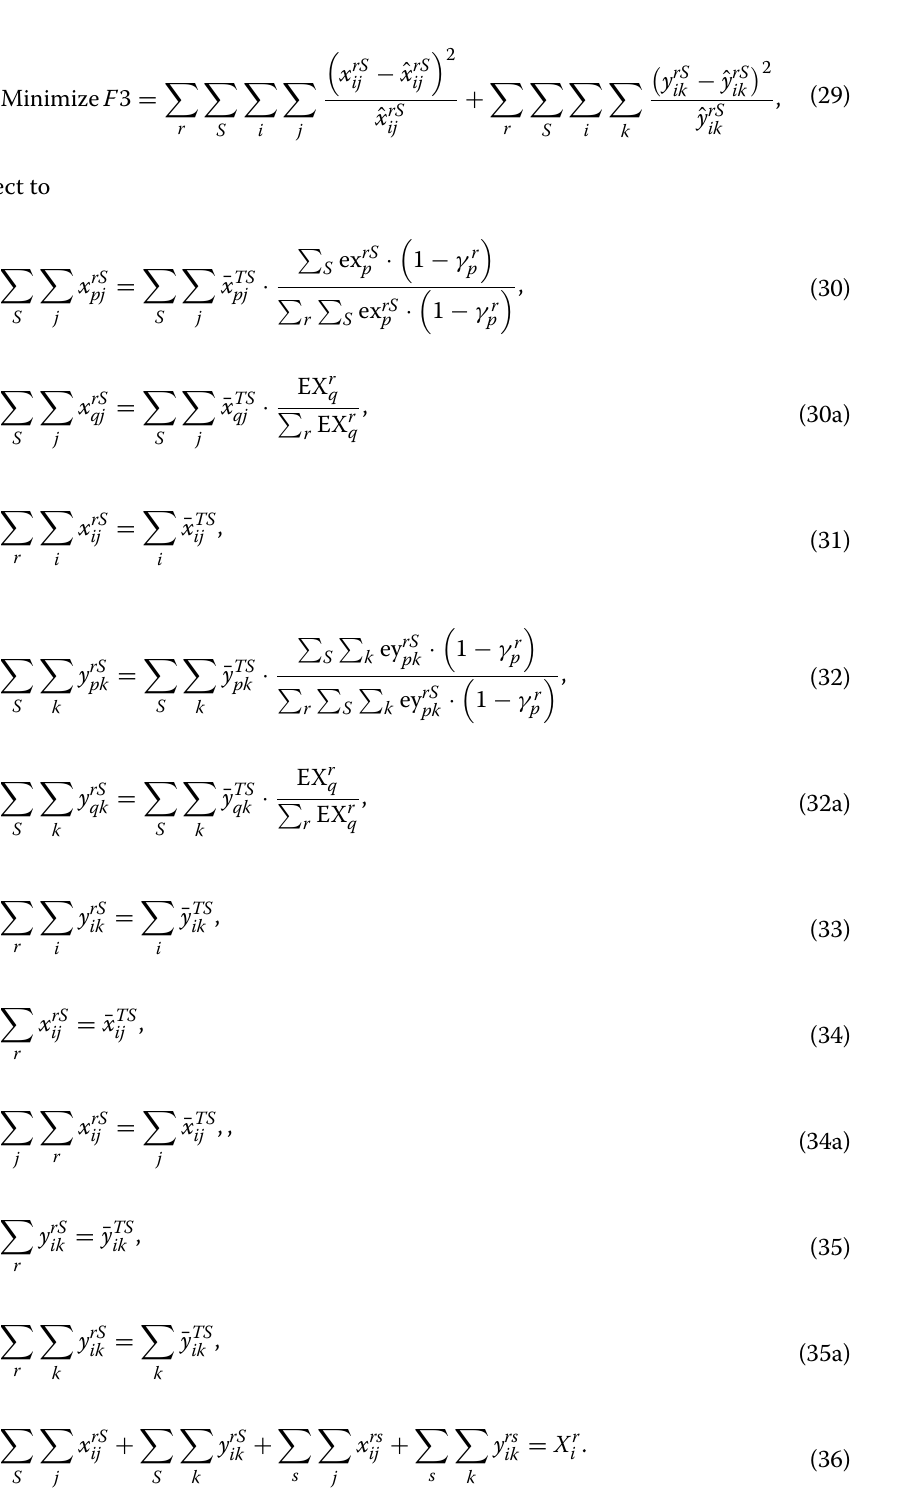
The balancing conditions row-wise (row control totals) in terms of the target coun- try’s regional exports are given by Eqs. (30) and (30a) for intermediate goods and ser- vices, respectively, and by Eqs. (32) and (32a) for final goods and services,